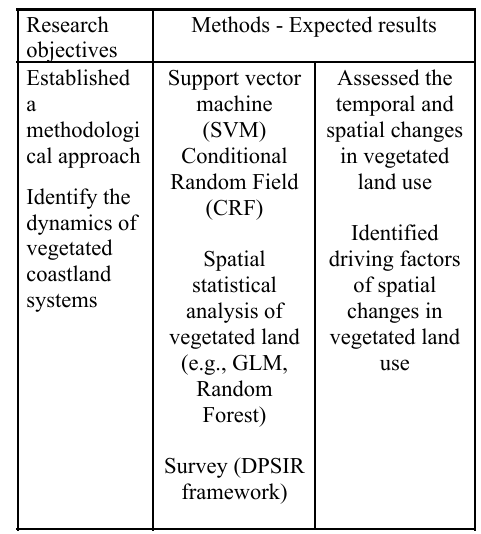
Table 1 . Research objectives, methods and expected